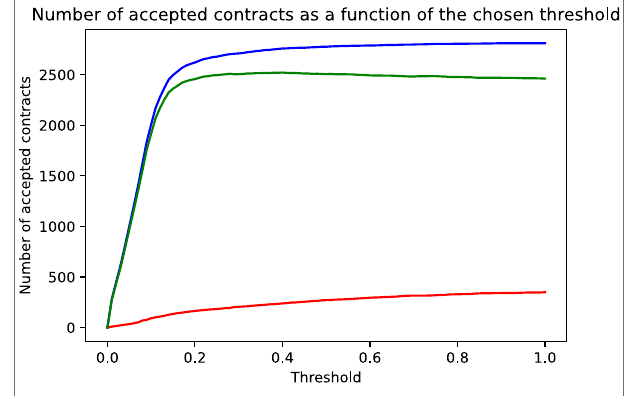
FIGURE3| Asafunctionofthechosenthresholdareshownthenumber of correctly accepted non-defaulting contracts (blue line), the number of incorrectly accepted defaulting contracts (red line) and the net effect, that is, the difference of correct and incorrect decisions re fl ecting the models accuracy (green